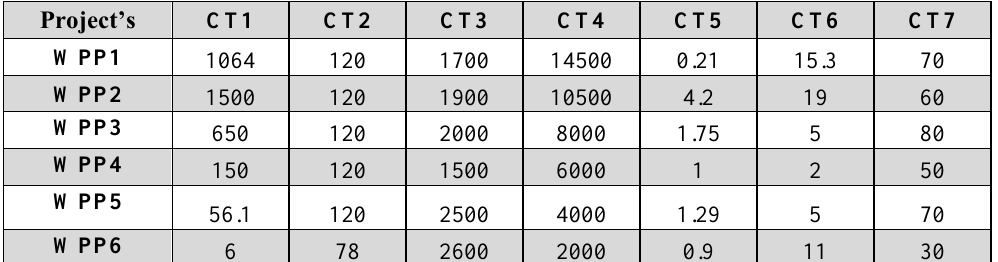
Table 8. Decision Matrix for projects